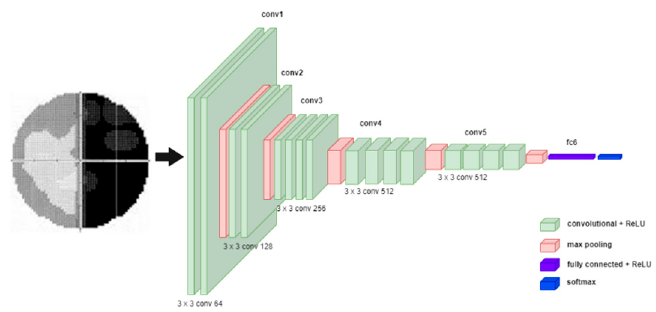
Figure 5. ResNet Model.